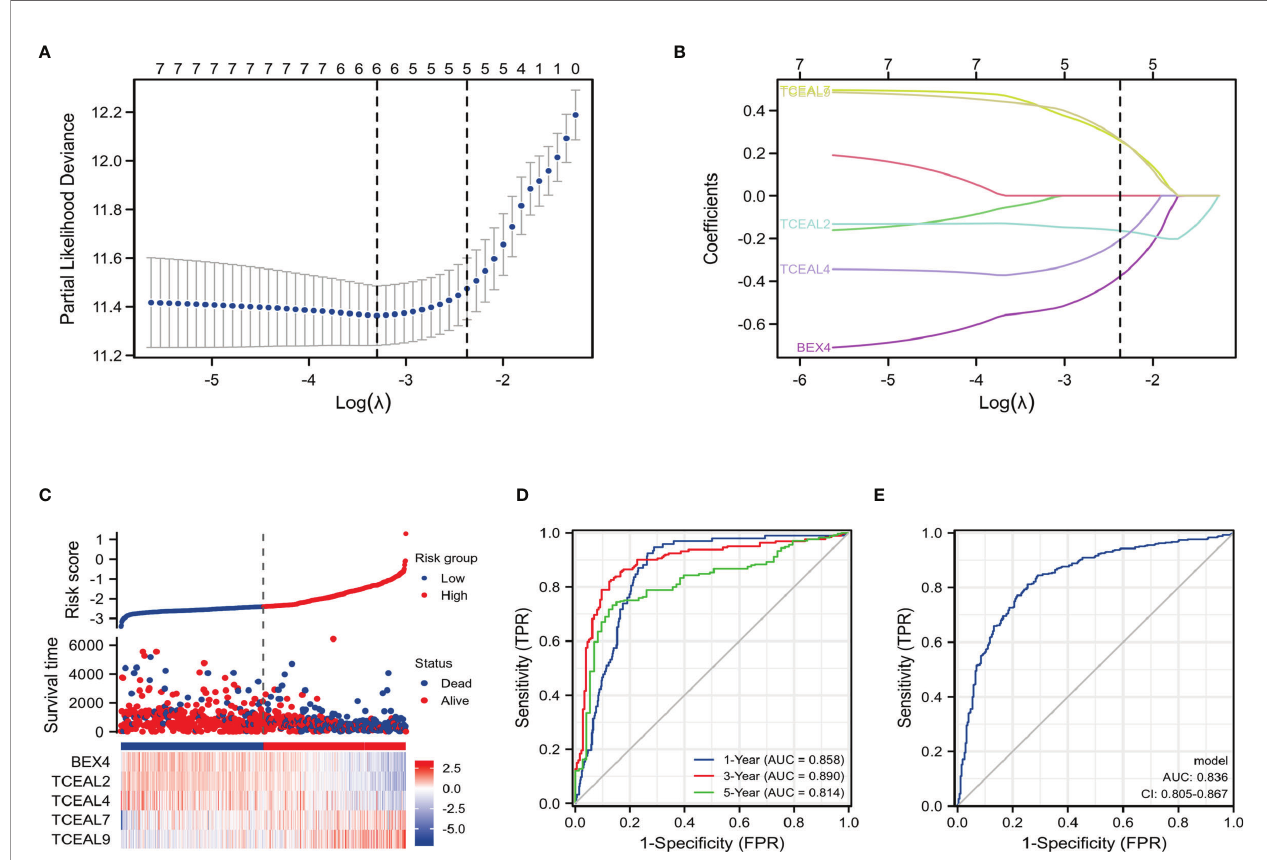
FIGURE 5 | LASSO Cox regression model of GBM and ROC curves analysis of LASSO Cox regression model. (A) Partial likelihood deviance of OS for the LASSO coef fi cient pro fi les. (B) LASSO coef fi cient pro fi les of the BEX4 and TCEAL2, TCEAL4, TCEAL7, and TCEAL9 expression for OS. (C) The survival time of GBM patients in the high-risk group was signi fi cantly shorter than that of patients in the low-risk group. (D) The time-dependent ROC curve; the AUC values of 1-, 3-, and 5-year OS were 0.858, 0.890, and 0.814, respectively. (E) The AUC value of the diagnostic ROC curve was 0.836. LASSO, least absolute shrinkage and selection operator; GBM, glioblastoma multiforme; ROC, receiver operating characteristic; OS, overall survival; AUC, area under the